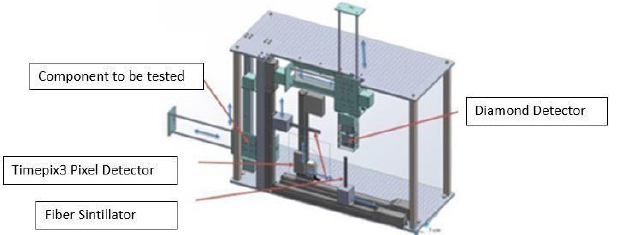
Fig. 9. Pretest test table of METU-DBL. Three detectors which are TimePix3 pixel detector, fiber scintillators are seen. The target area is scanned with 3 mm accuracy and flux measurement are taken at regular intervals. Device under test is positioned based on these measurements so that the required homogeneity is